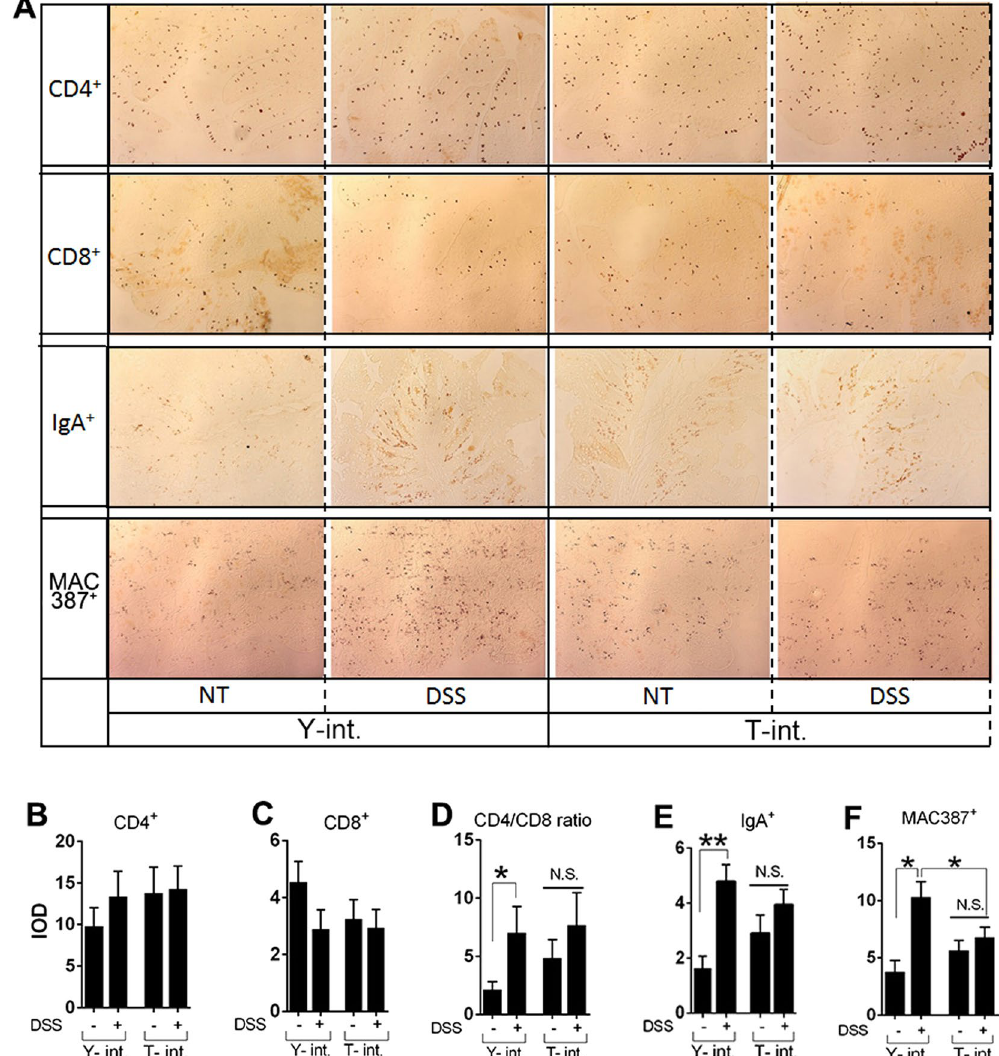
Figure 5. Immune cells in transplanted pigs was evaluated by Immunohistochemistry. ( A ) Immunohistochemistry to evaluate CD4 + T cells, CD8 + T cells, IgA + plasma cells and MAC387 + macrophages. ( B – F ) Quantitative analyses of these positive reactions are presented in the bar graphs (n = 6 for each group). The intensity of staining was quantified using the Image-Pro Plus software. Representative graphs with integrated optical density (IOD) readings are expressed as arbitrary units (AU) ± the SEM. * P < 0.05; ** P < 0.01. N.S., no significant